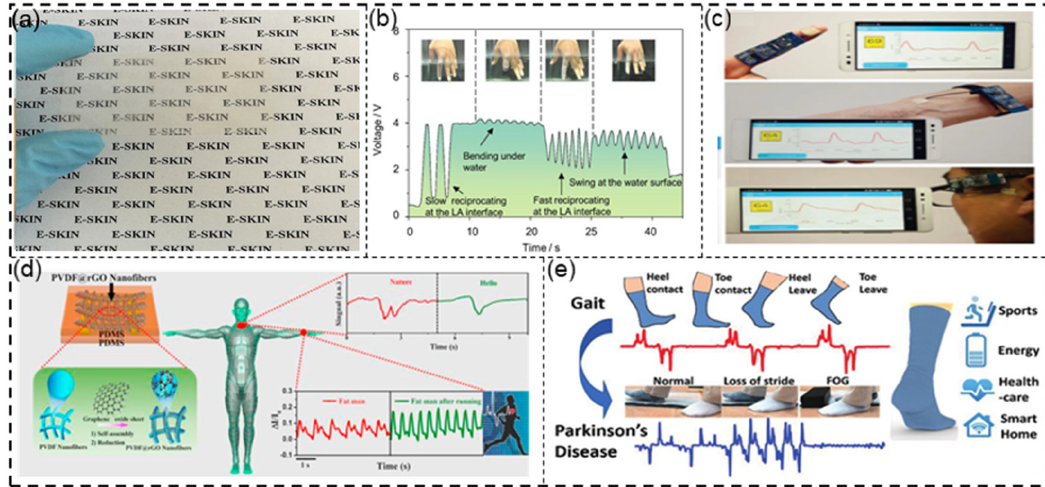
Figure 10. ( a ) Electronic skin using gold electrodes to simulate neuronal cells. Reprinted with permission from Ref. [129]. Copyright 2018 American Chemical Society. ( b ) Sketch of the S-LSNG attached to the fingers as a self-powered sensor. Reprinted with permission from Ref. [131]. Copyright 2020 Elsevier. ( c ) Highly sensitive graphene-based pressure sensors for applications as e-skins and wearable electronics. Reprinted with permission from Ref. [139]. Copyright 2016 Elsevier.